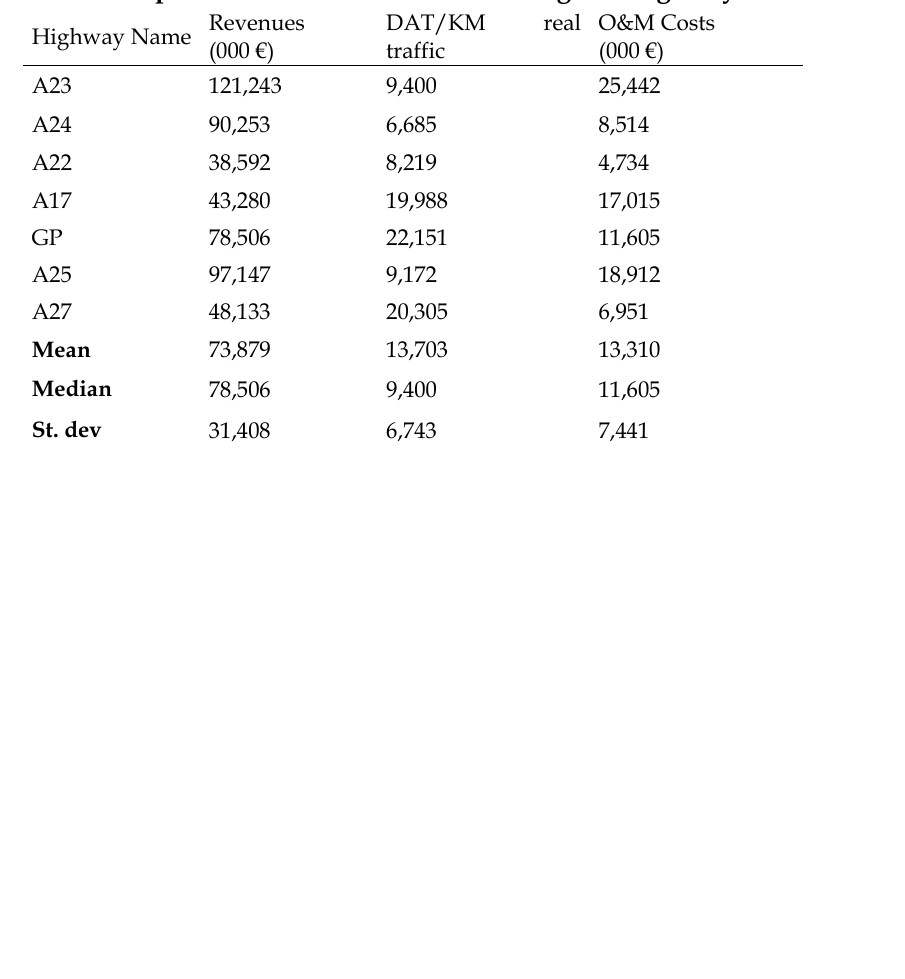
Table 3. Operational characteristics of Portuguese